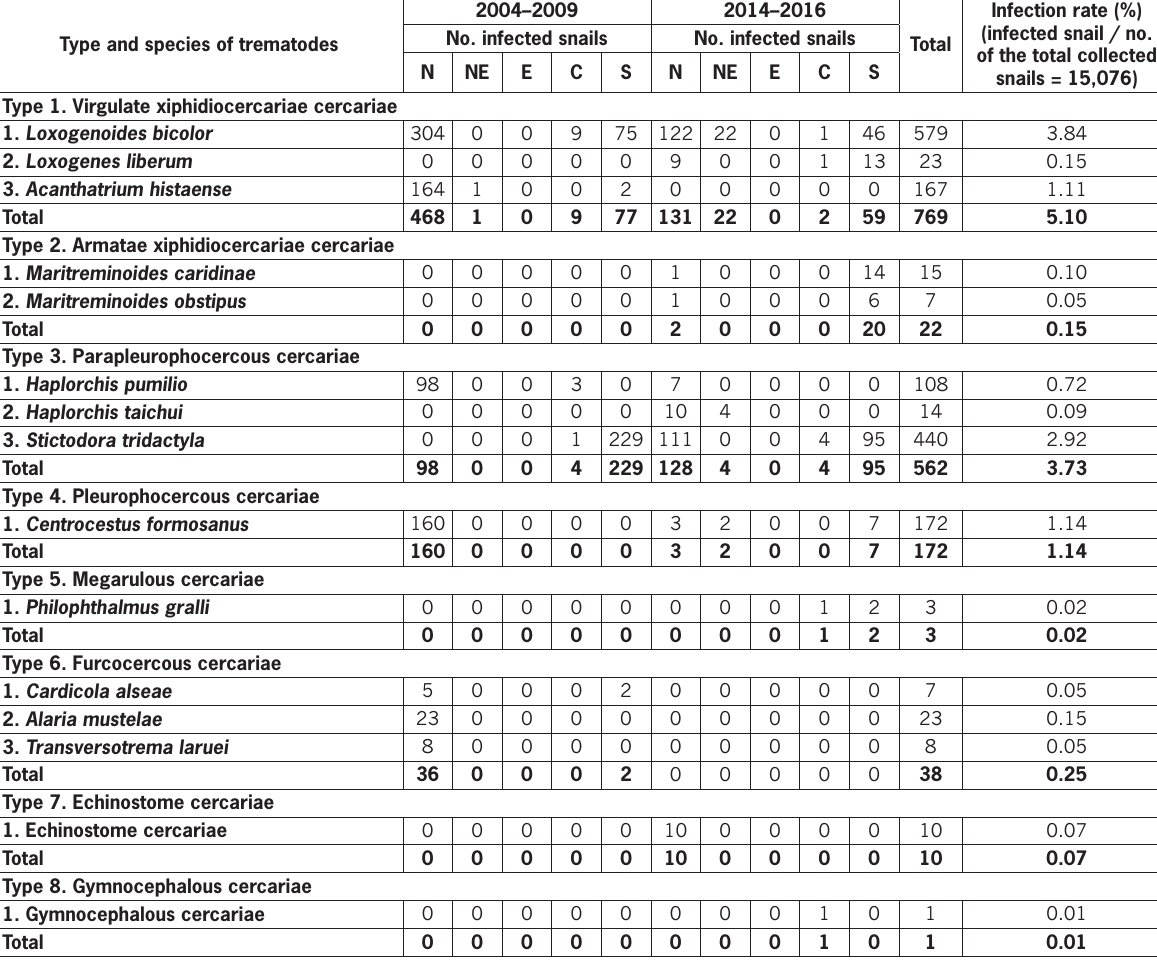
Table 3. Distribution of trematodes obtained from Tarebia granifera (A total of 15,076 snails) in Thailand (N = North, NE = North- east, E = East, C = Central, S = South).